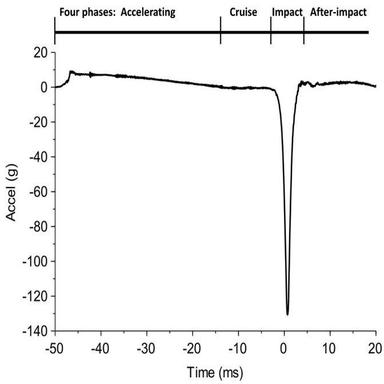
Typical acceleration time history of a gel block, including phases of the initial acceleration (− 50 to − 12 ms), cruise (− 12 to − 2.5 ms), impact (− 2.5 to 4 ms) and after-impact (4 ms and beyond).